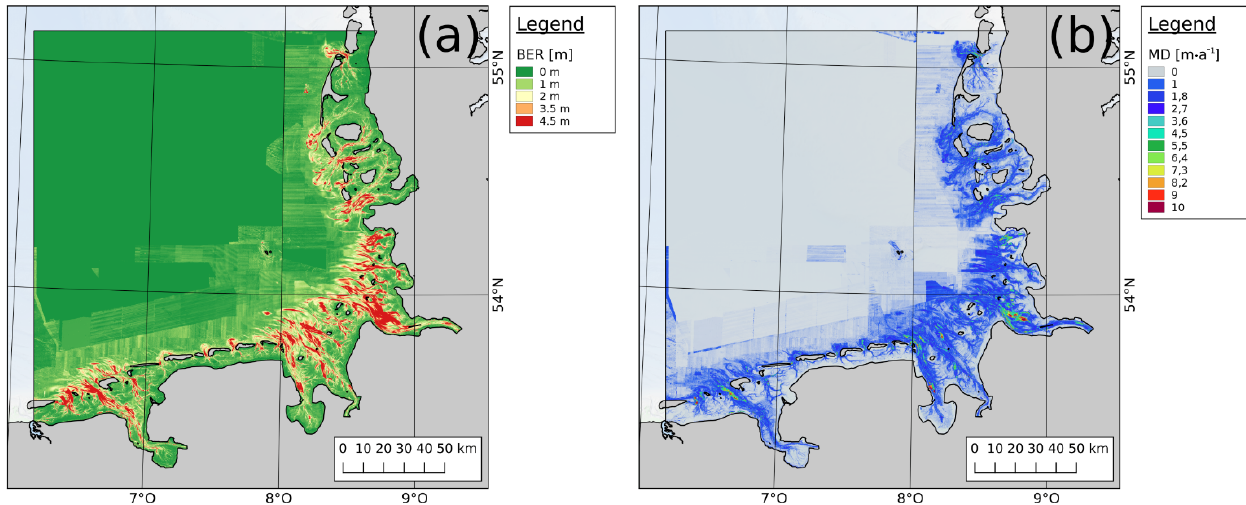
Figure 8. Bathymetric gridded analysis products: (a) bed elevation range and (b) morphological drive.